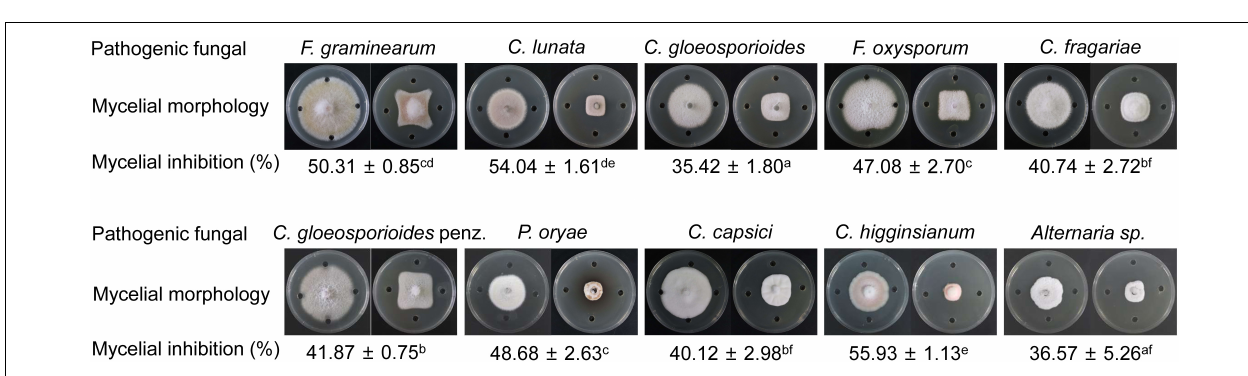
kalimantacin A ( Supplementary Figure 3 ). Four gene clusters (cluster1, cluster2, cluster4, and cluster5) presented a 100% similarity with the known compounds. However, 2 out of 14 clusters exhibited a 13% similarity with the predicted compounds, suggesting that these clusters might be involved in the biosynthesis of novel